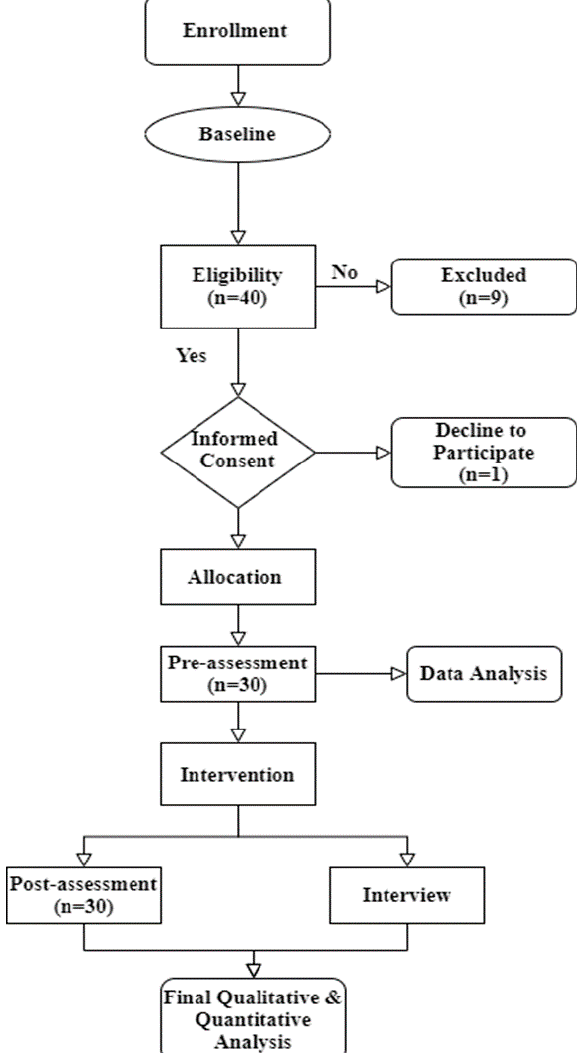
Figure 1. Research flowchart of the